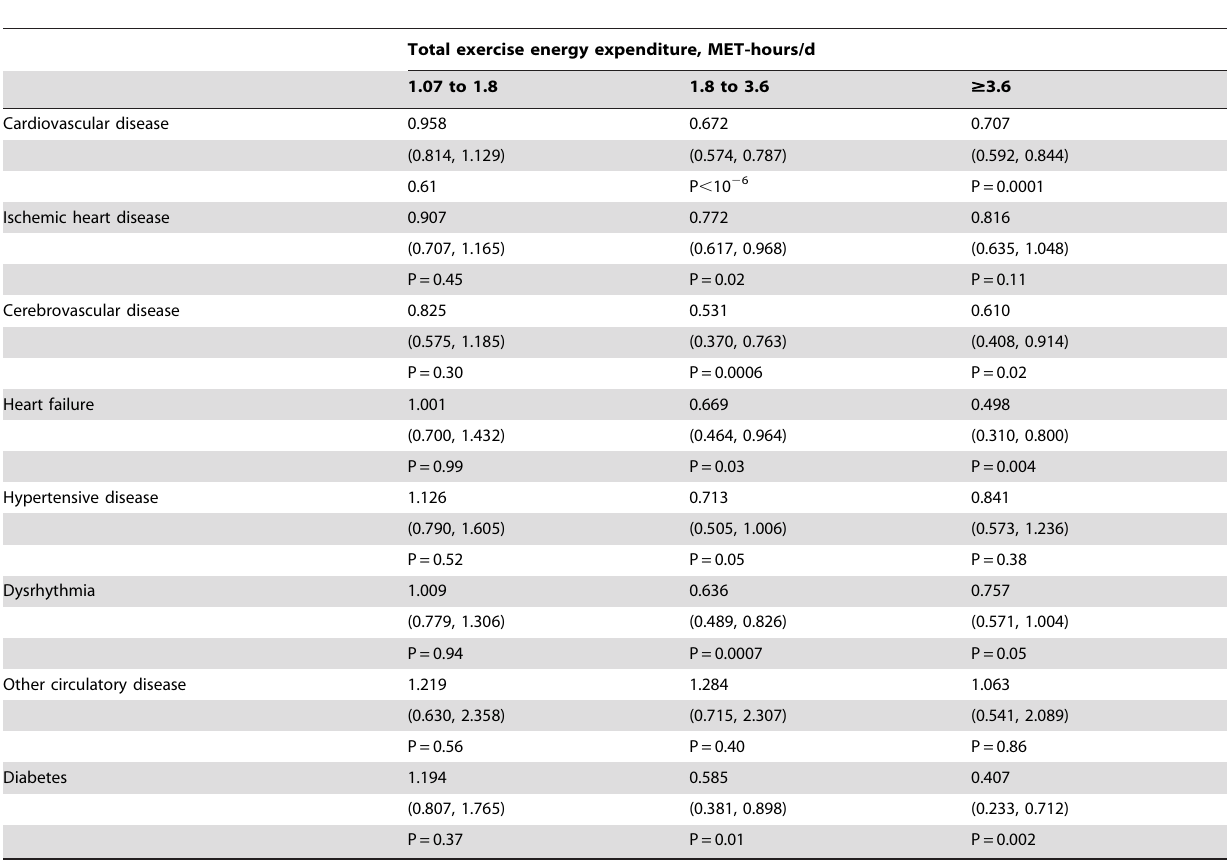
Table 7. Survival analyses of all related mortality, i.e., underlying or contributing causes of death, vs. categories of physical activity adjusted for medication use and BMI baseline .